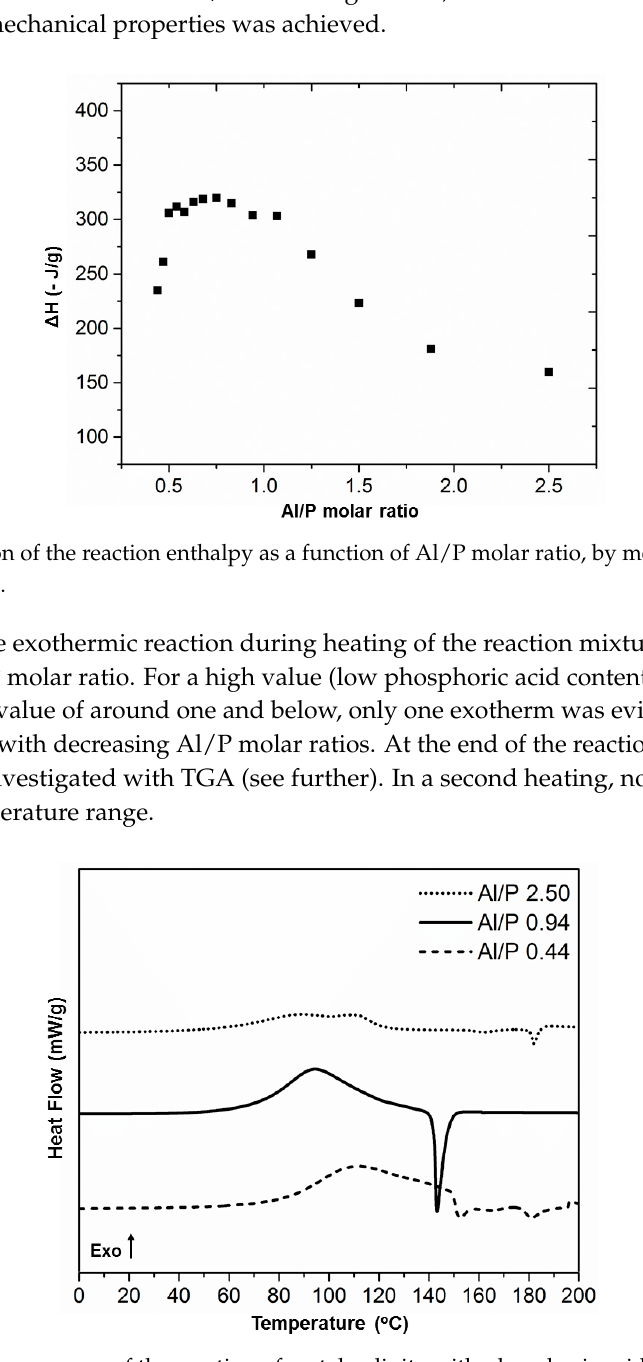
Figure 3. DSC thermograms of the reaction of metakaolinite with phosphoric acid with variation of Al/P molar ratios.